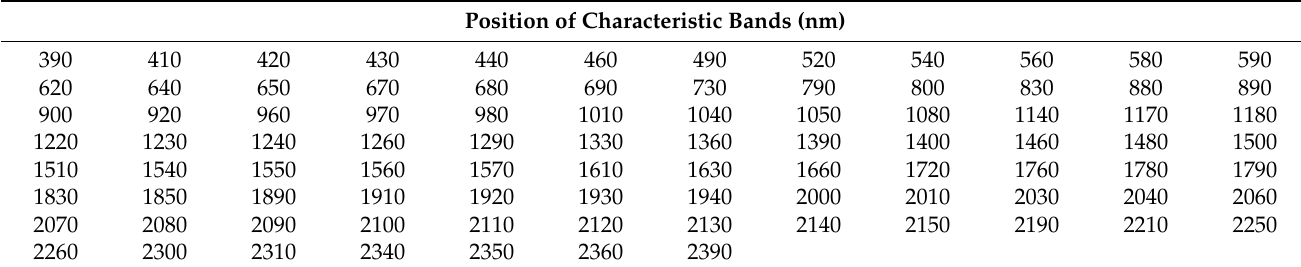
Table A2. Characteristic bands of CR selected by GA.